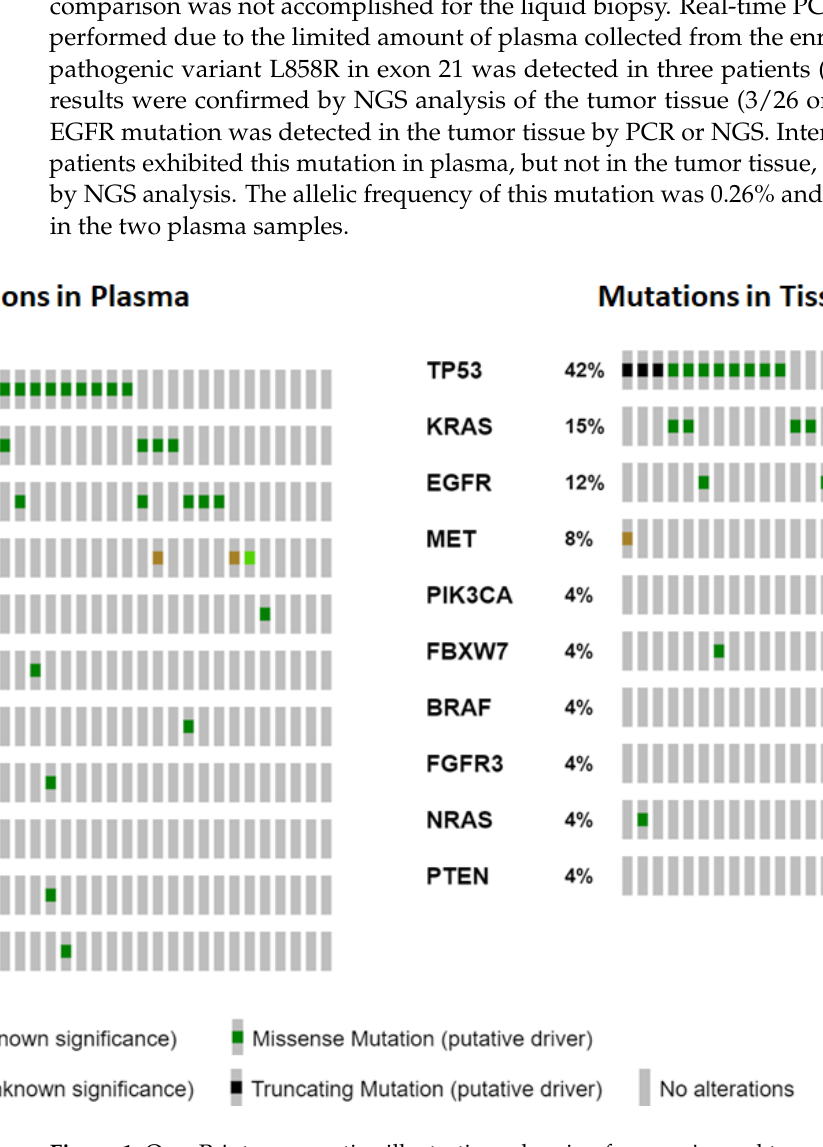
Figure 1. OncoPrint comparative illustrations showing frequencies and types of alterations for the identified genes (rows, sorted by percent alterations) in the study patients (columns) for both plasma samples (left) and tissue samples (right) (https://www.cbioportal.org/oncoprinter (Access date: 5 November 2022)).